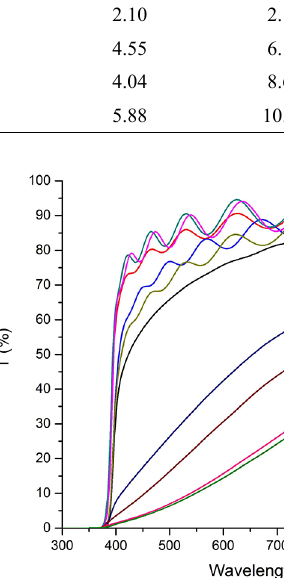
Figure 8. Optical transmittance spectra for ZnO films deposited with different substrate temperatures